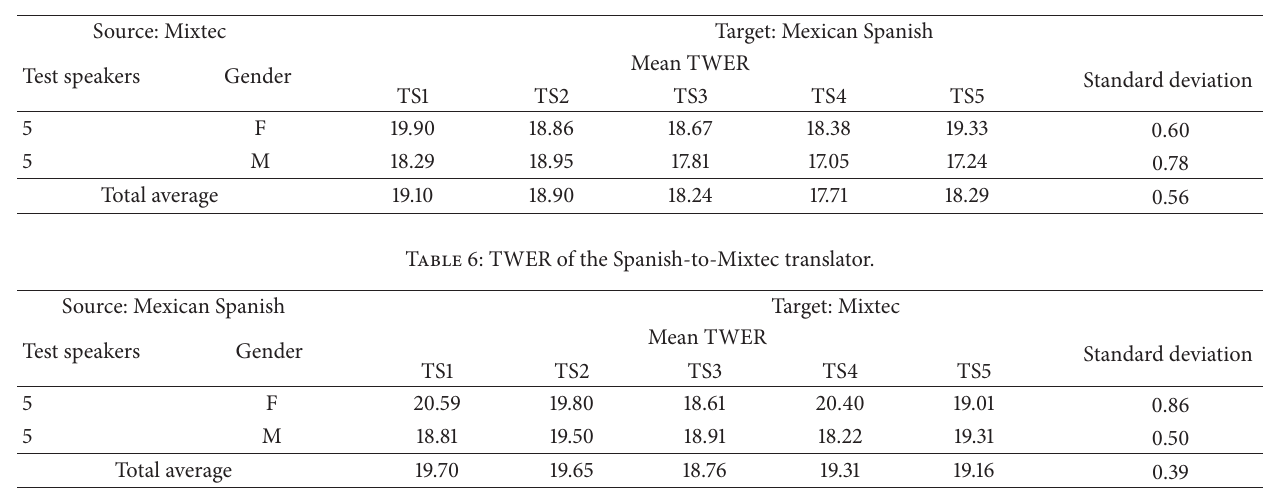
Table 5: TWER of the Mixtec-to-Spanish translator.